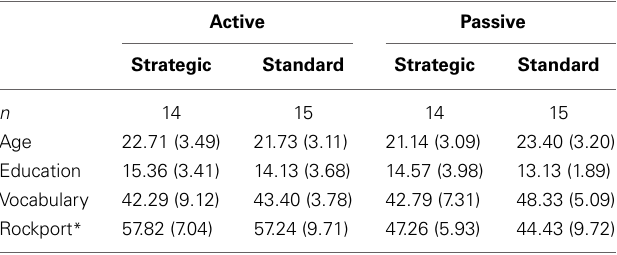
Table 1 | Demographic